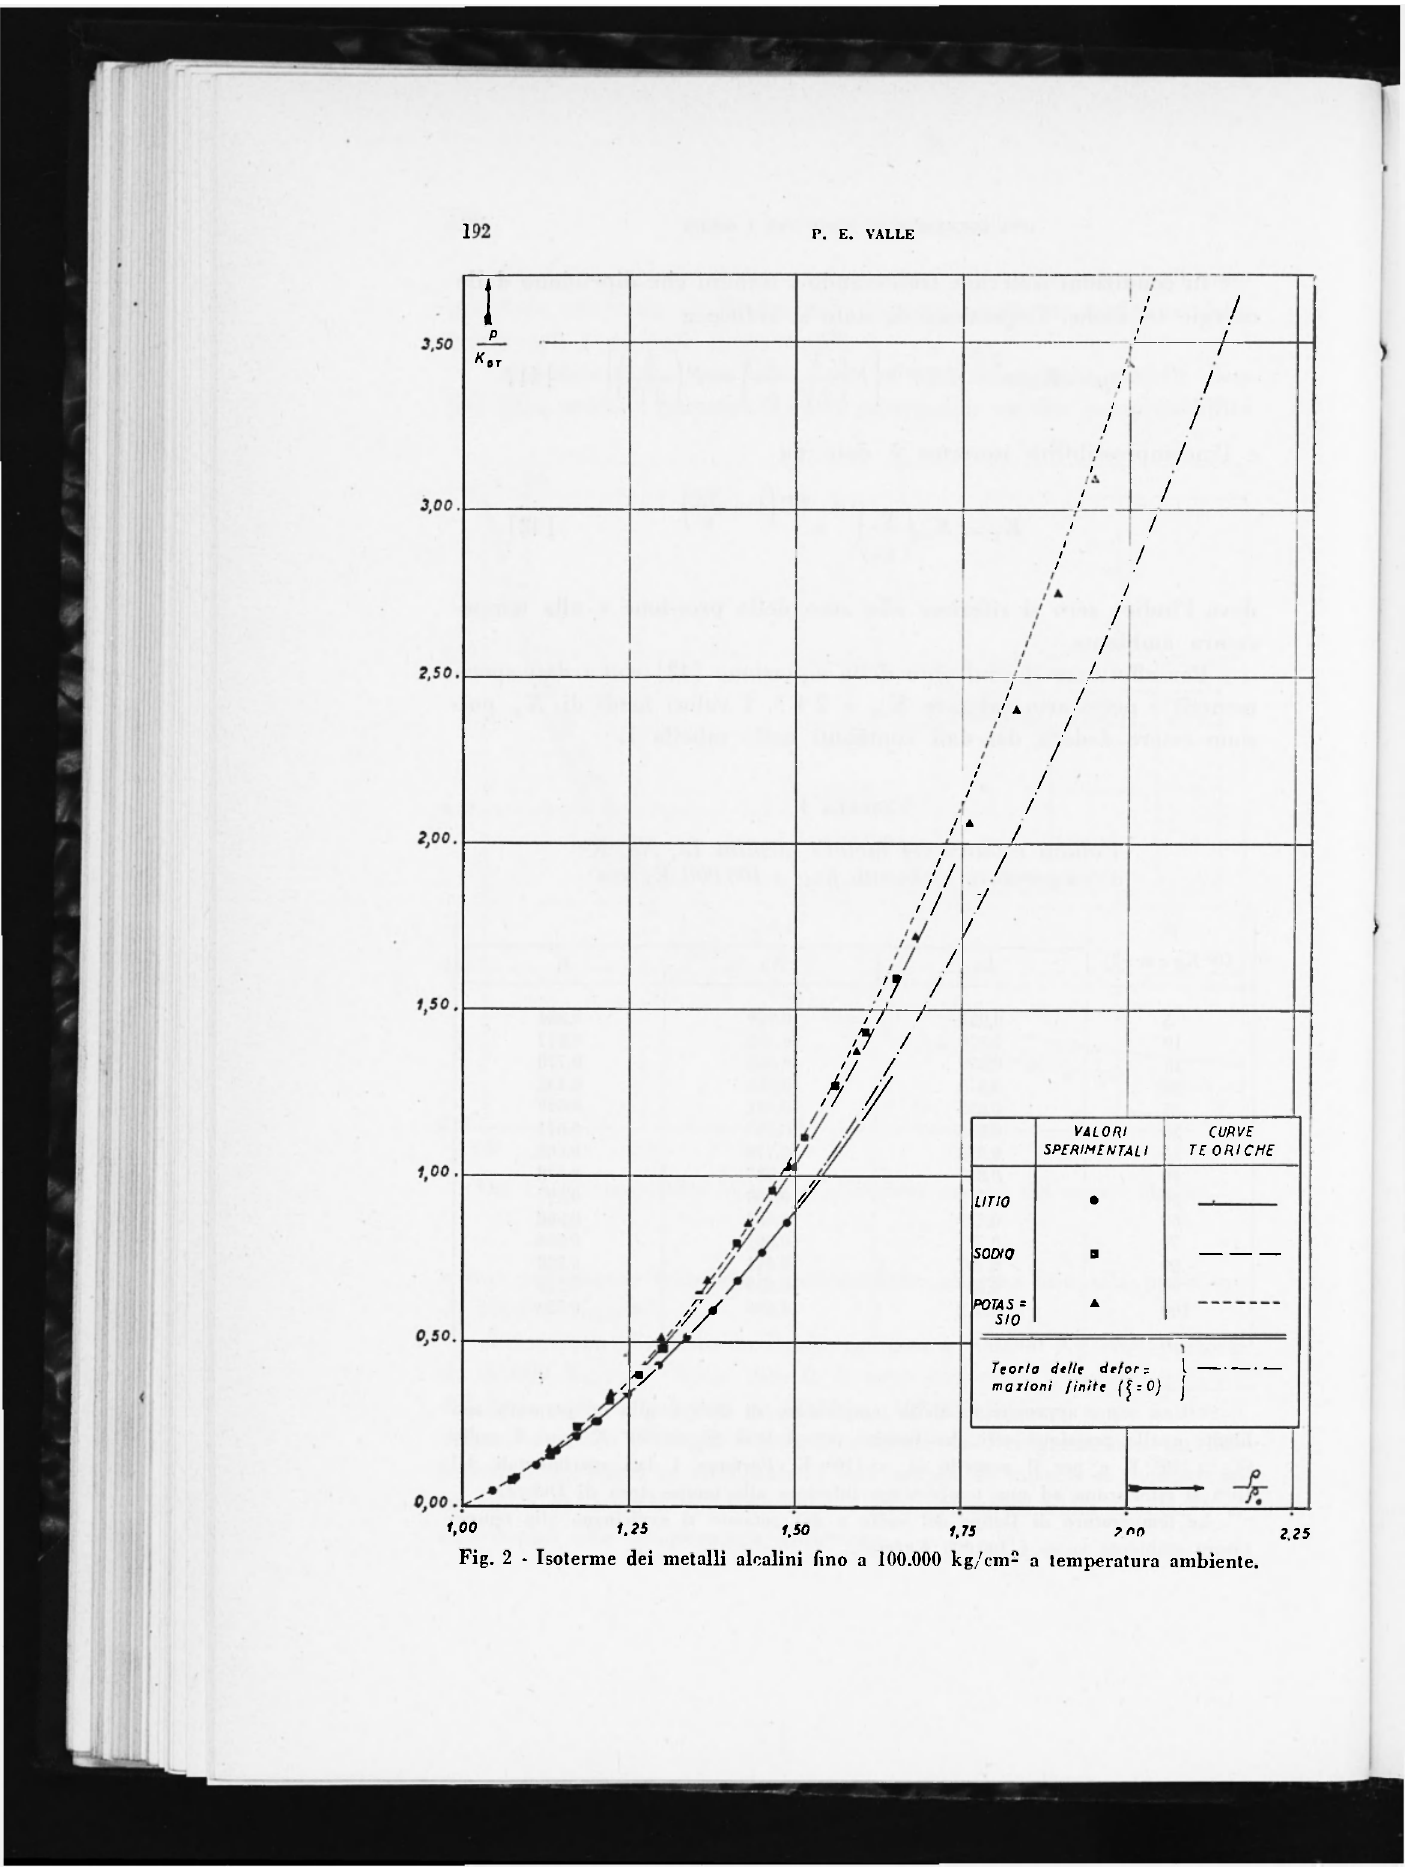
Fig. 2 - Isoterme dei metalli alcalini fino a 100.000 kg/cm 2 a temperatura